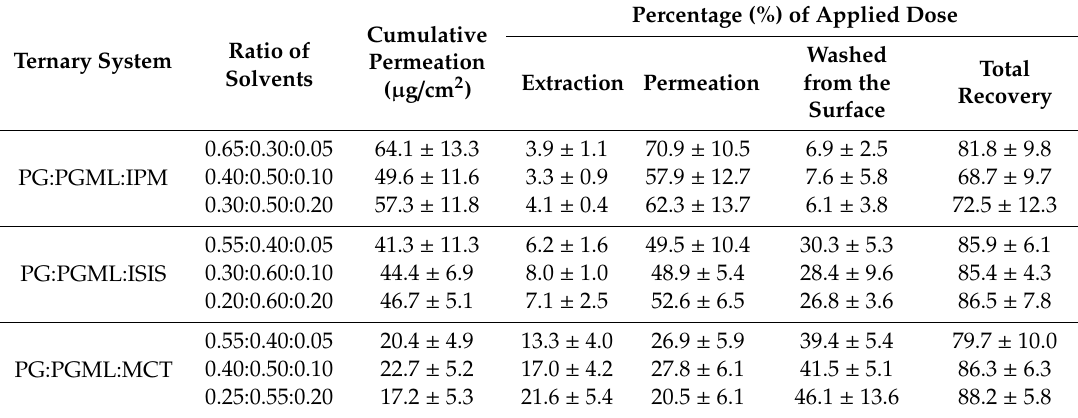
Table 3. Cumulative permeation and percentage (%) recovery values of EA for ternary solvent systems following mass balance studies ( n = 5; mean ±